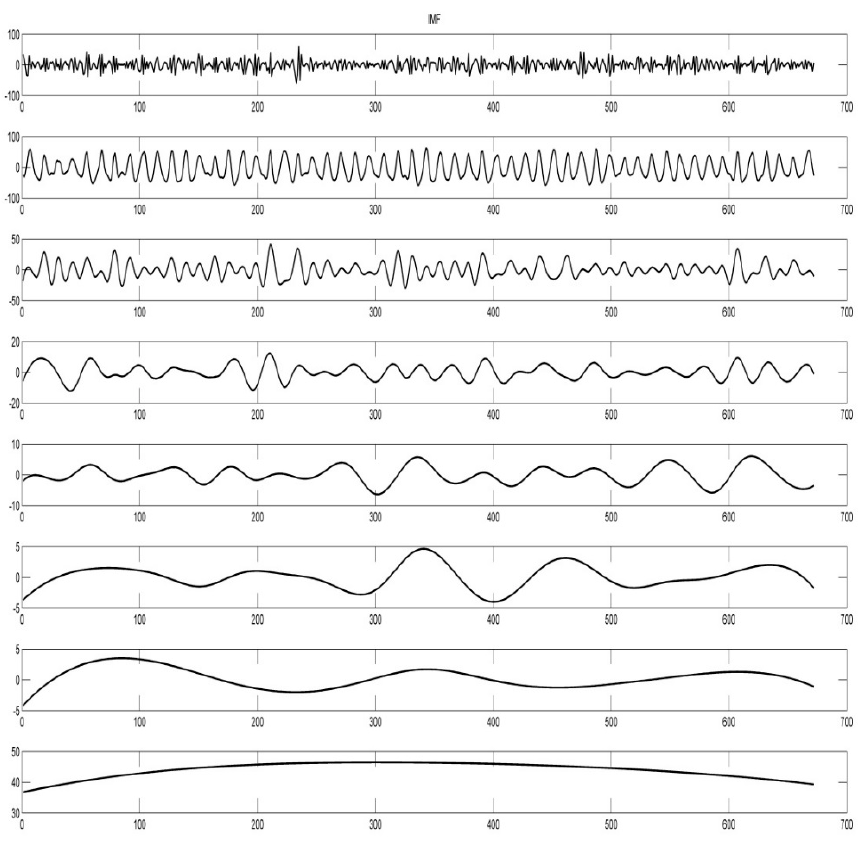
Figure 6. The decomposition of the hydrological data by EEMD.